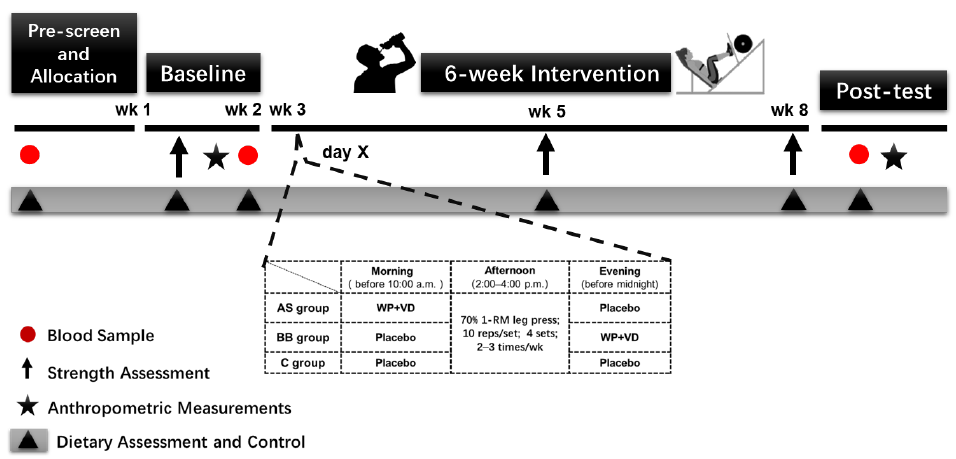
Figure 1. Experimental protocol.